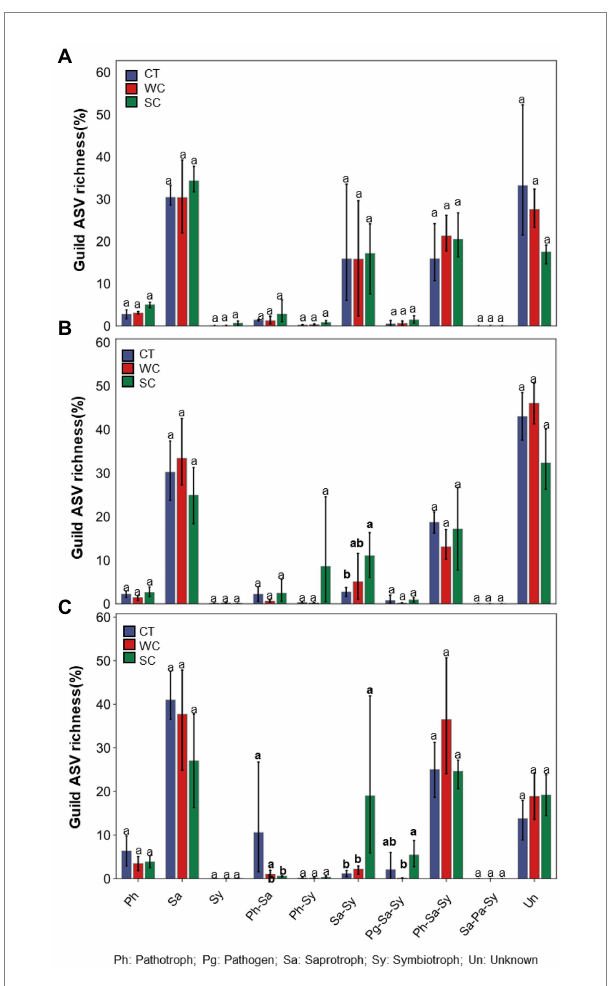
FIGURE 5 Funguild predictions of functional fungal guild ASV richness of the conventional tillage (CT), weed cover (WC) and Siratro cover (SC) treatments in the intercropping area in 2018 (A) , 2019 (B) and 2020 (C) . Means within the same year followed by the same letters are not significantly different at p = 0.05 according to a protected LSD